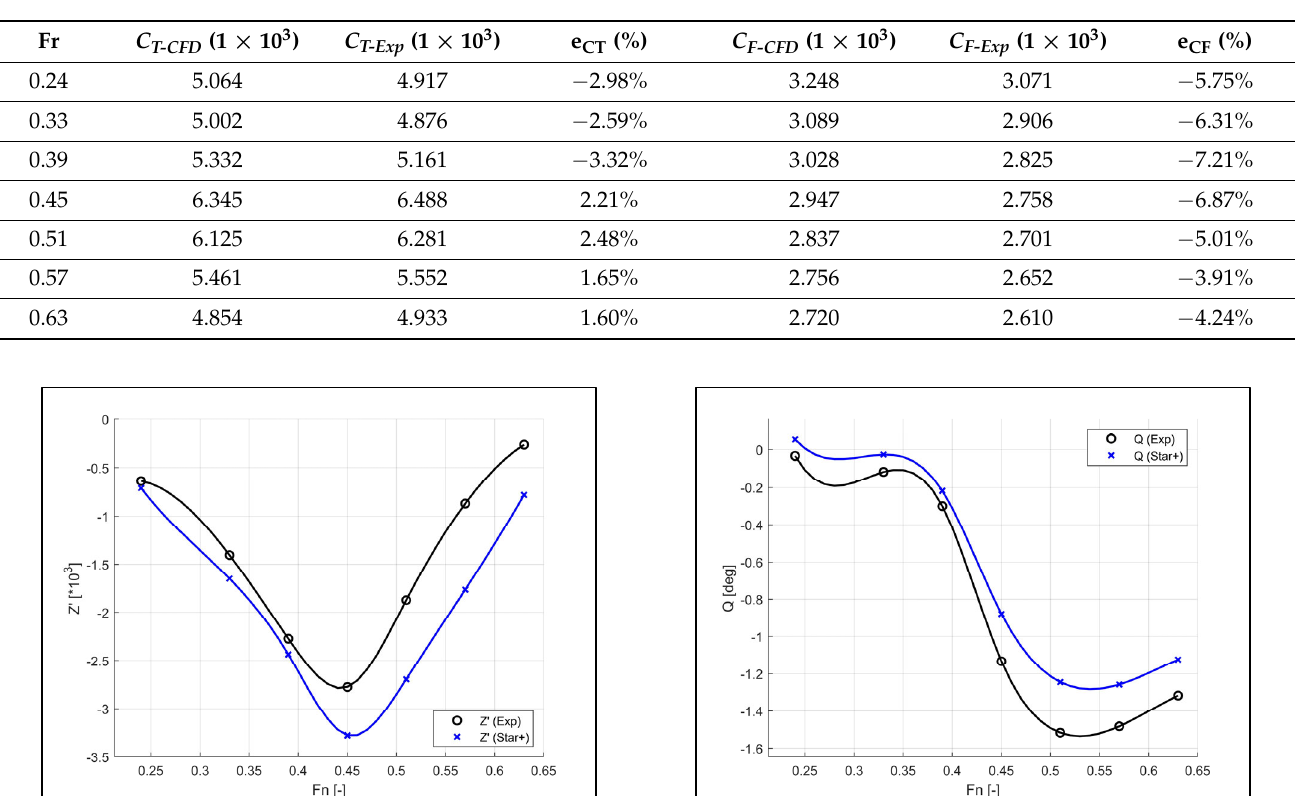
Table 6. Full scale sinkage and trim comparison for